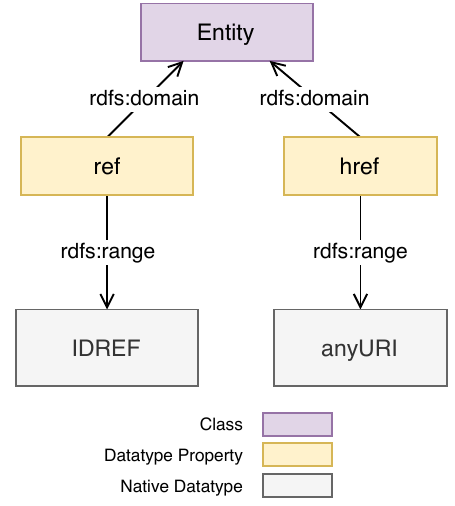
Figure 5. Model of ontology generated from example in Fig. 2 1 https://technical.buildingsmart.org/standards/ifc/ifc-schema- specifications/ 2 http://schemas.opengis.net/citygml/